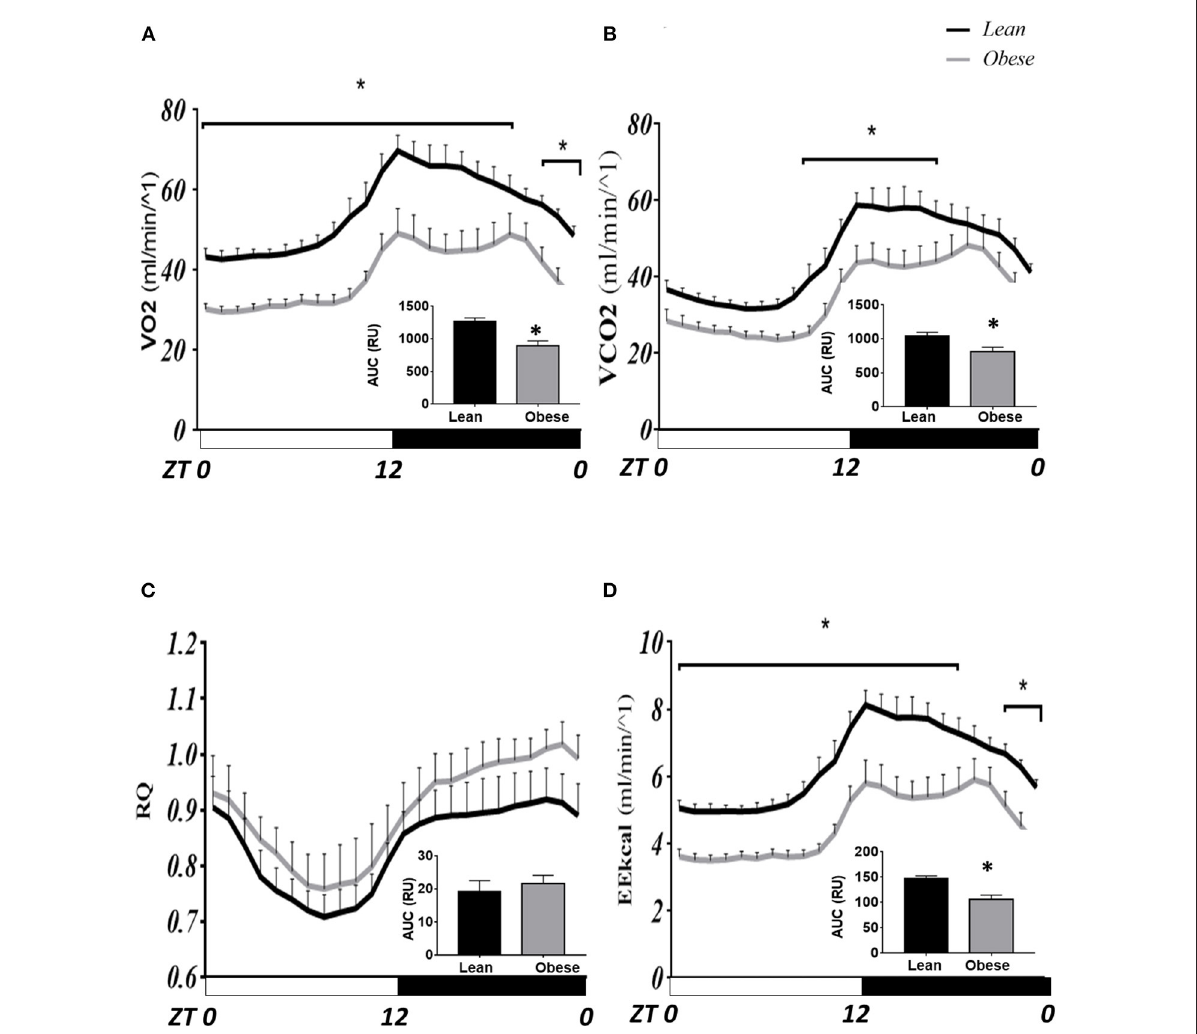
FIGURE1 Comparative daily profile of calorimetry parameters in mice N. alstoni . Data are presented as mean ± SEM, n = 10 lean, n = 5 obese. Lean (black line), Obese (gray line). Bars depict the LD cycle. * Significant differences intergroup (two-way ANOVA, P < 0.05). (A) VO 2 intake; (B) VCO 2 production; (C) Respiratory ratio; (D) Energy Expenditure